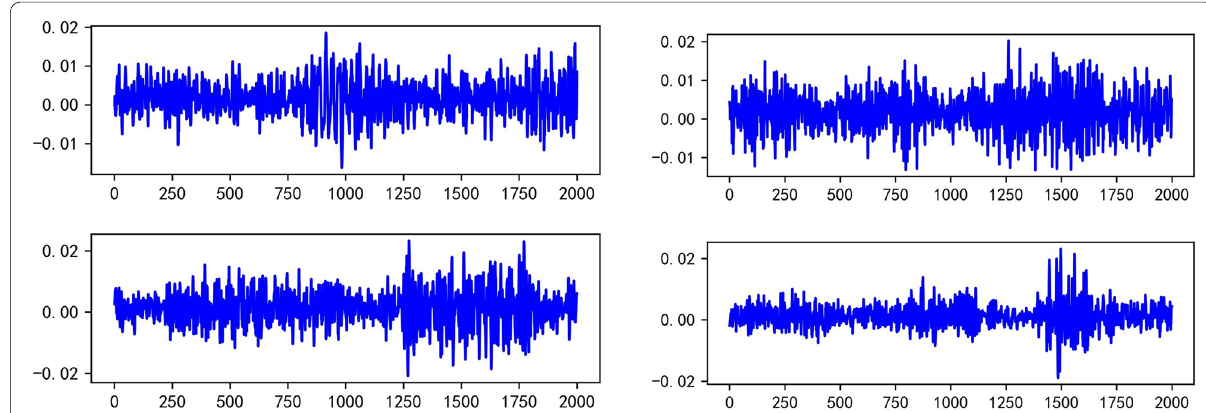
Fig. 7 Vibration waveforms of faulty bearings. This figure shows the time domain vibration waveforms of each bearing fault. (Upper left) (a) Ball fault (Upper right) (b) Combined fault (Lower left) (c) Inner fault (Lower right) (d) Outer